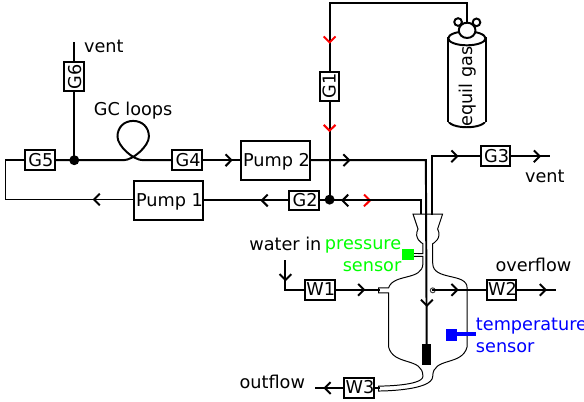
Figure 3. Schematic of the equilibration system. For circuit opera- tion see